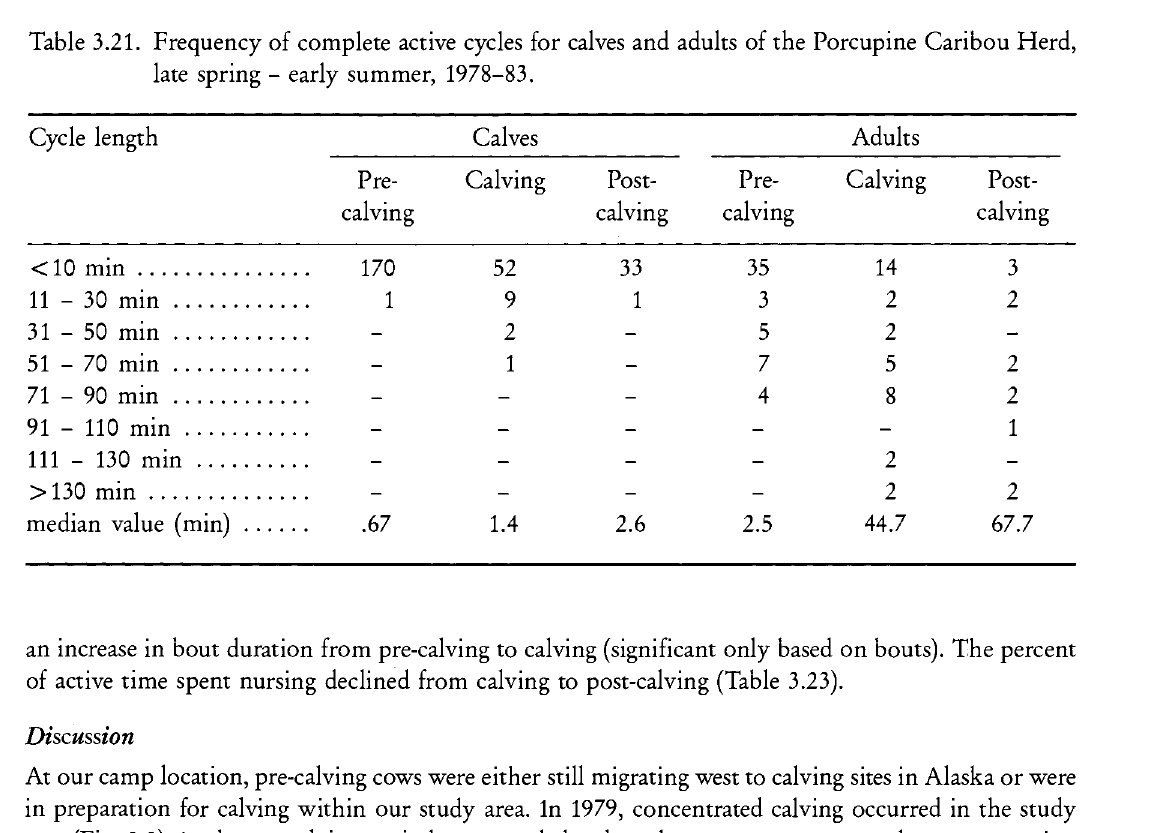
Table 3.21. Frequency of complete active cycles for calves and adults of the Porcupine Caribou Herd, late spring - early summer, 1978-83. Cycle length Calves Adults Calving Post- Pre- Calving calving calving